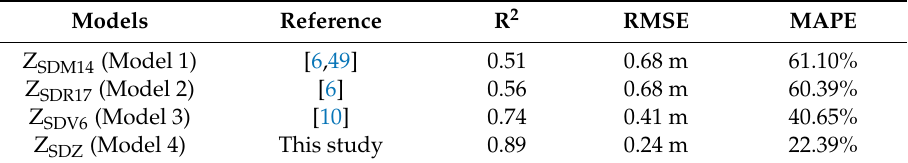
Table 3. Comparison of performance between the existing semi-analytical Z SD models. Models